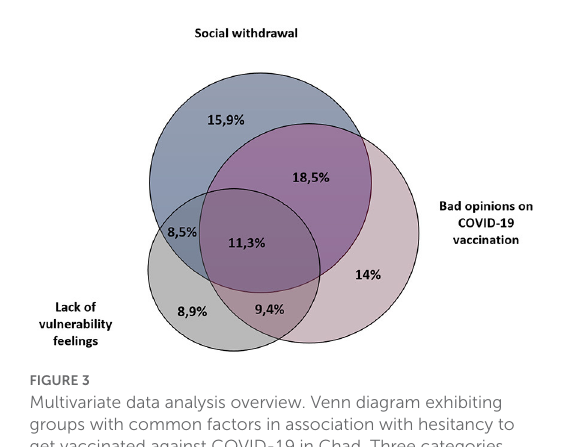
FIGURE3 Multivariate data analysis overview. Venn diagram exhibiting groups with common factors in association with hesitancy to get vaccinated against COVID-19 in Chad. Three categories have been established: (1) Participants “with a bad opinion of the COVID-19 vaccination”; (2) participants with “lack of vulnerability feelings” and (3) participants considered to be in a “social withdrawal”